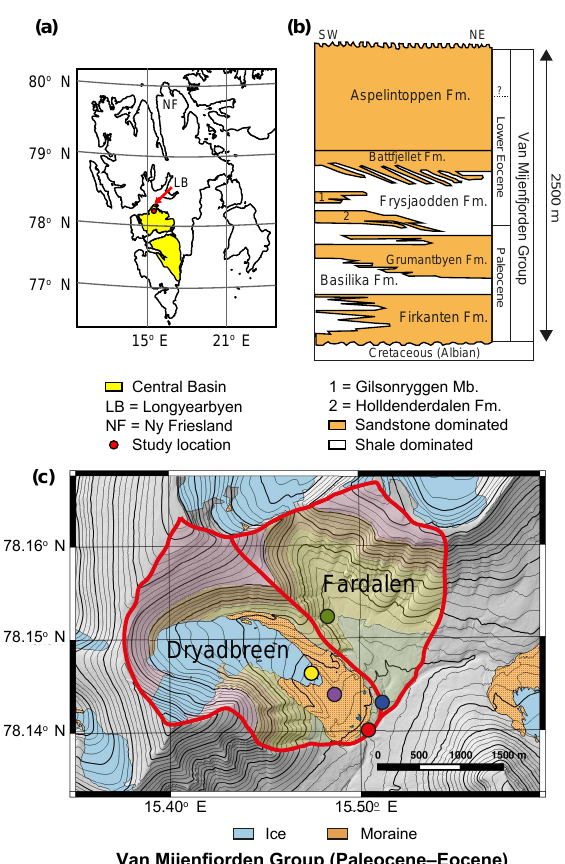
Figure 2. (a) Map of Svalbard indicating the extent of the Pale- ogene Central Basin. The location of the study area in relation to Longyearbyen is also indicated. (b) The stratigraphy of the Van Mi- jenfjorden Group adapted from Cui et al. (2011). The catchments are located at the north-east side. (c) Topographic map of the sedi- ment sampling locations with the geology of the catchments super- imposed. Glaciers and their moraines are shown in blue and orange respectively and contours are displayed at 50m intervals. The solid red lines demarcate the catchment boundaries. Dryadbreen is on the left and Fardalen on the right. The coloured circles indicate where samples referred to in Table 1 were collected: R01 and G (green circle); supraglacial stream suspended sediment sample, R03, R04 and D (yellow); Fardalen stream suspended sediment sample and L (blue); Dryadbreen stream suspended sediment sample and O (red); R02 (purple). Other rock and sediment samples referred to in Ta- ble 2 were collected at various locations within the two catchments. Geological information is taken from (Major et al., 2000) and the topographic information is based on GIS data from the Norwegian Polar